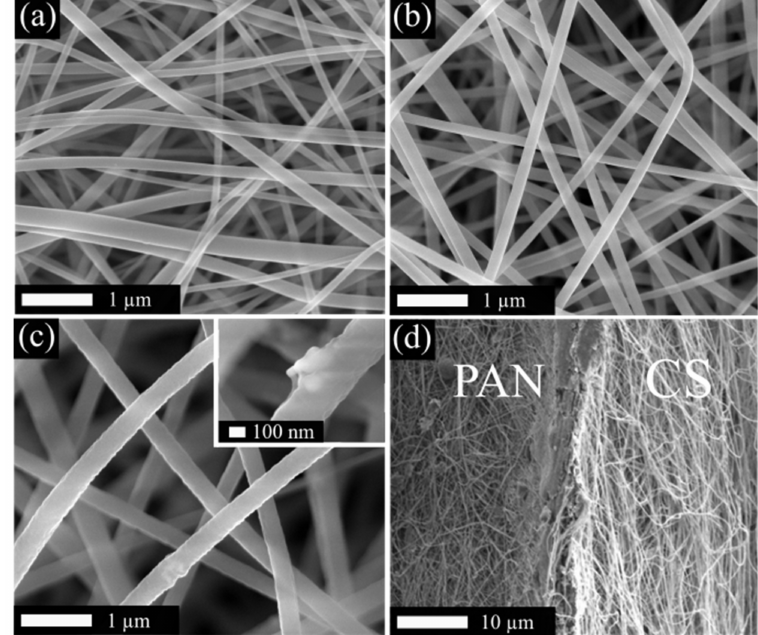
Figure 1. SEM images of the bilayer PAN–CS mat from the side of ( a ) PAN and ( b ) CS. The image of PAN / ZnO–CS from the side of PAN / ZnO is shown in ( c ). The cross-section of the PAN–CS bilayer at the interface is depicted in ( d ).